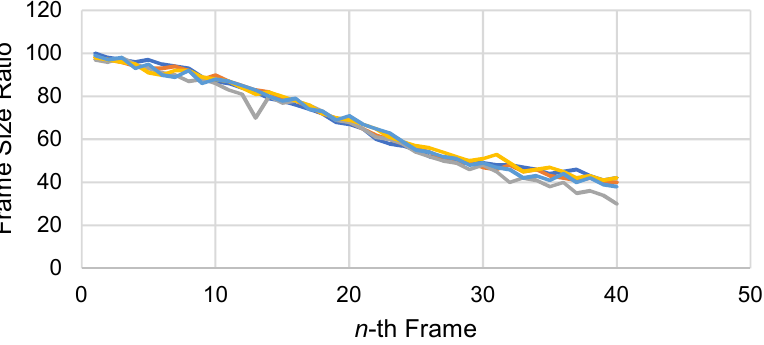
Figure 10. Frame size ratio in the n -th frame.